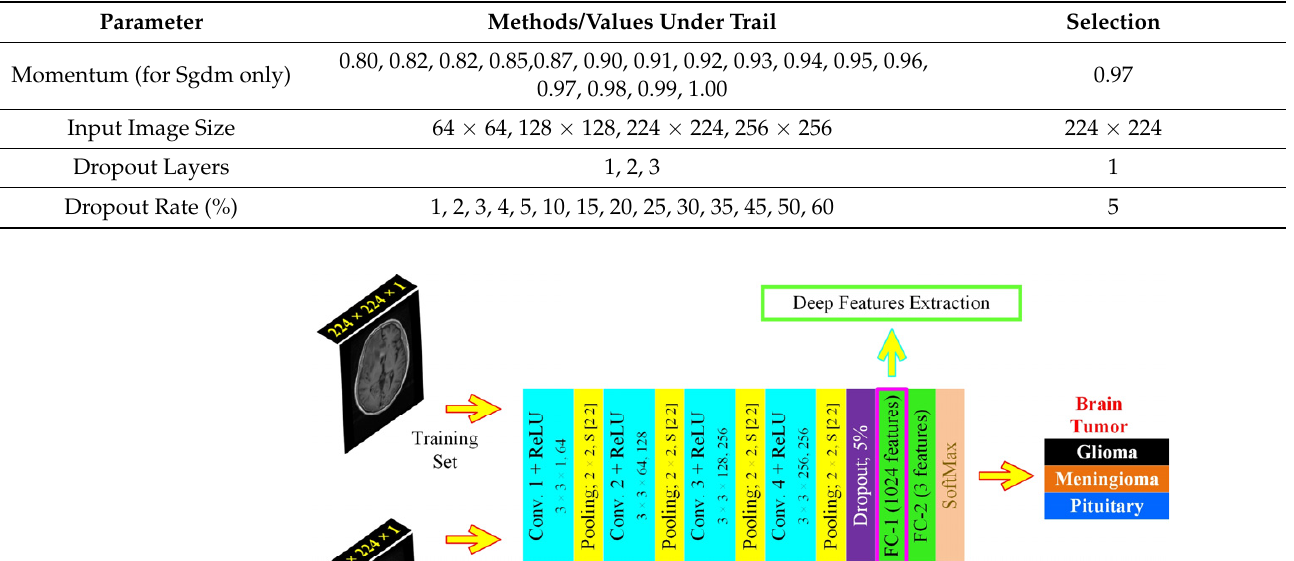
extraction (Conv. stride [1 1] and padding is “same”).